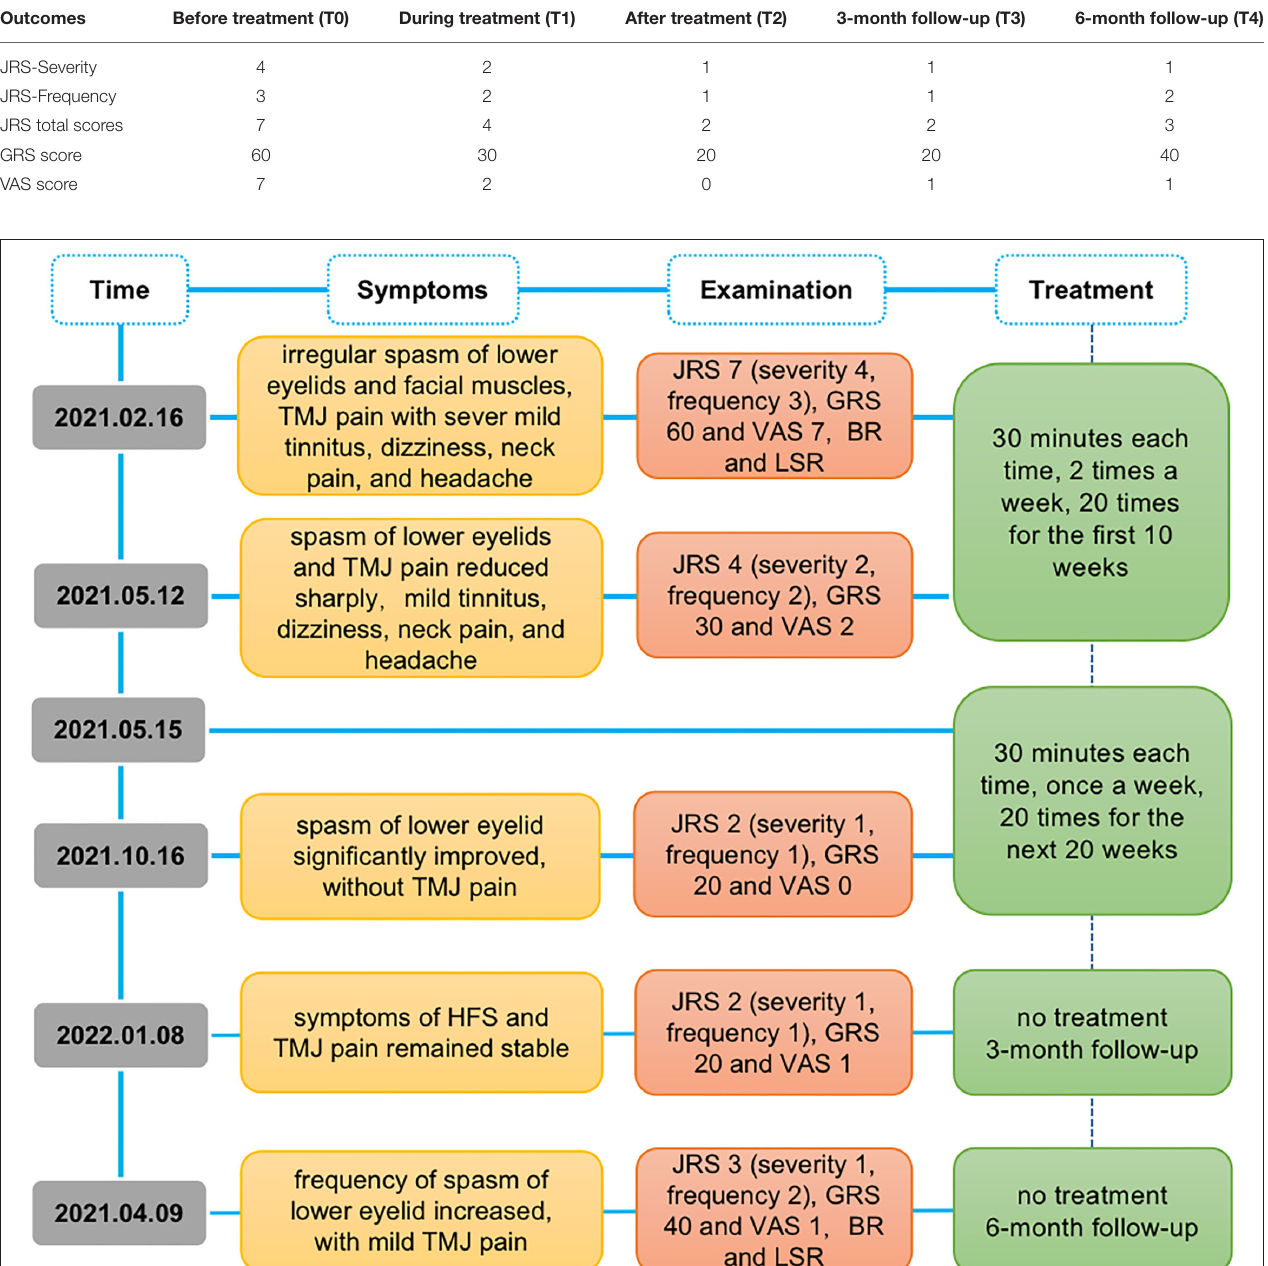
TABLE 1 | Clinical assessments for HFS and TMJ pain at each time points. Outcomes